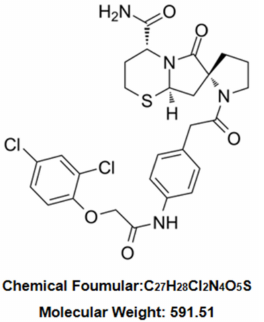
Figure 1. Chemical structure of